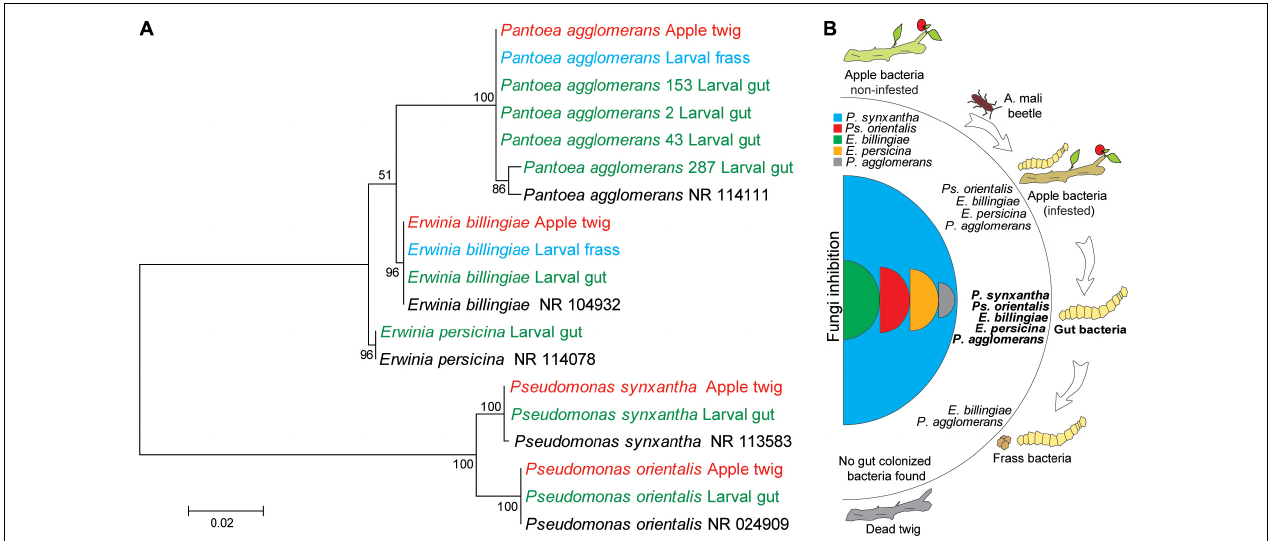
FIGURE 7 | Identity analysis of the gut bacteria and possible route of bacterial transmission to larvae. (A) Clustering of bacterial species from the larval gut, apple twig-associated bacteria, and frass. The evolutionary history was inferred by using the maximum likelihood method based on the Tamura–Nei model. The percentage of replicate trees in which the associated taxa clustered together in the bootstrap test (500 replicates) is shown next to the branches. The evolutionary distances were computed using the Tajima–Nei method and are in units of the number of base substitutions per site. Distance scale represents the number of differences between the sequences. Evolutionary analyses were conducted in MEGA 7. Bacterial species in black, red, and green words relate to GenBank, apple twigs, and the gut bacteria, respectively. (B) Possible mechanism of transmission of tree bacteria to the larval